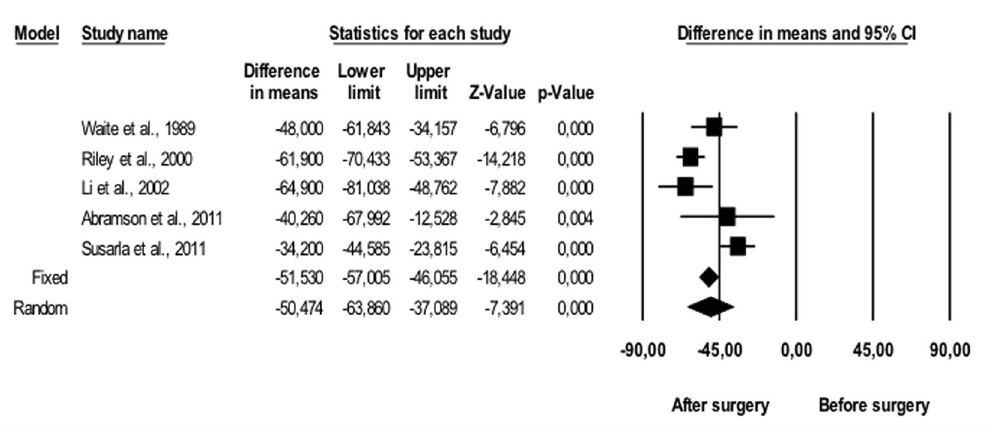
Figure 4. Changes in RDI (events/hour). Decrease in respiratory disturbance index following bimaxillary advancement surgery. Meta-analysis.